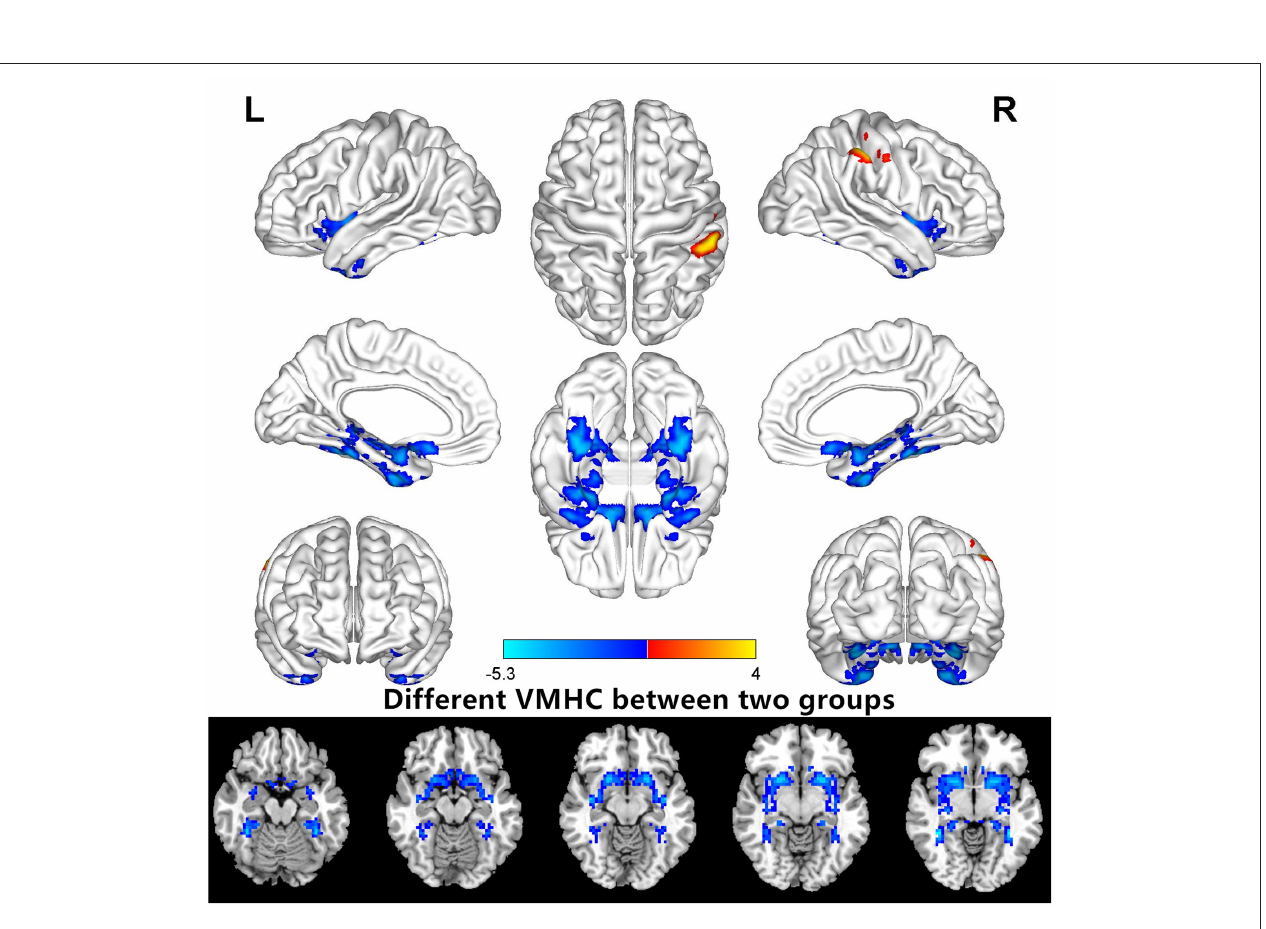
Frontiers in Human Neuroscience | www.frontiersin.org 4 June 2022 | Volume 16 | Article